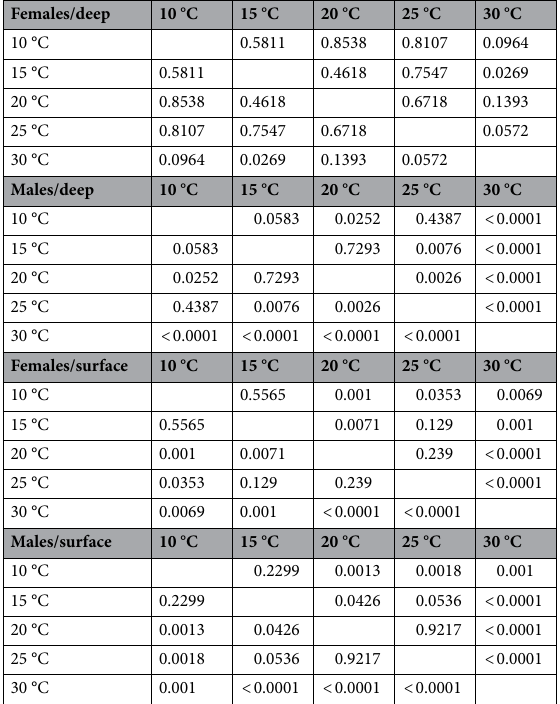
Table 3. p -values of the lowest SO 2 values after cooling at different